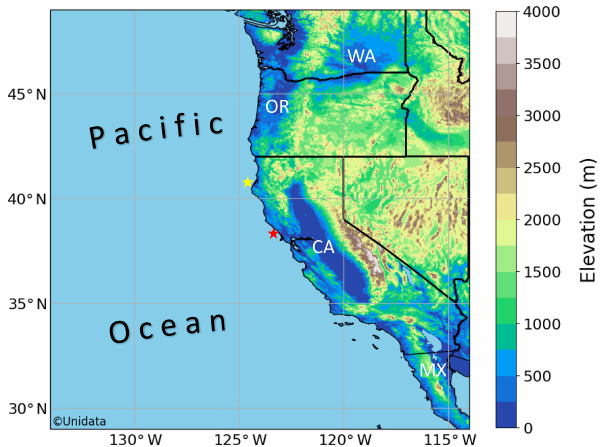
Figure 1. Study region covering the western United States and the NEP for the SOM analysis. United States abbreviations WA, OR, and CA represent Washington, Oregon, and California, respectively, while MX represents Mexico. The red and yellow stars denote the locations of buoys 46013 (Bodega Bay) and 46022 (Eel River), re-